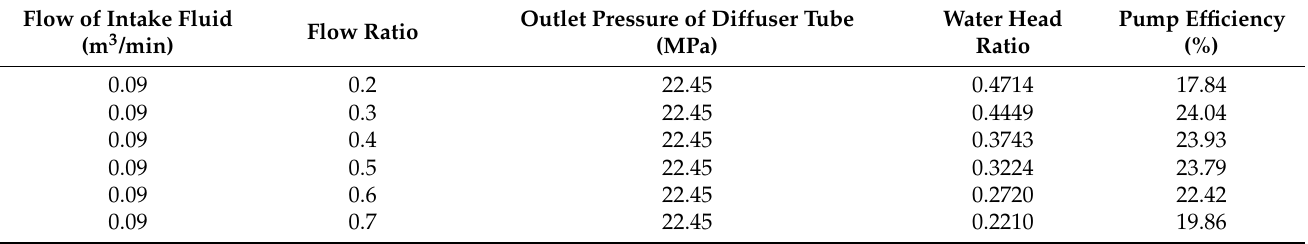
Table 8. Effect of different flow rates on pump efficiency.